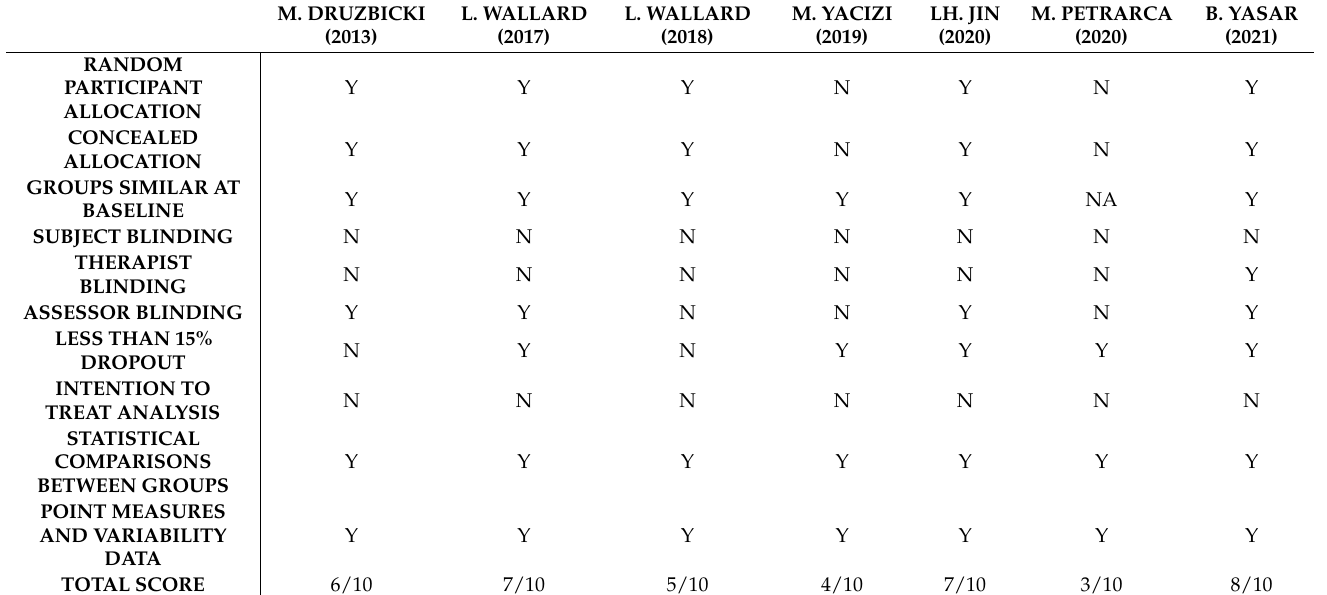
Table 2. Assessment of methodological quality using the PEDro